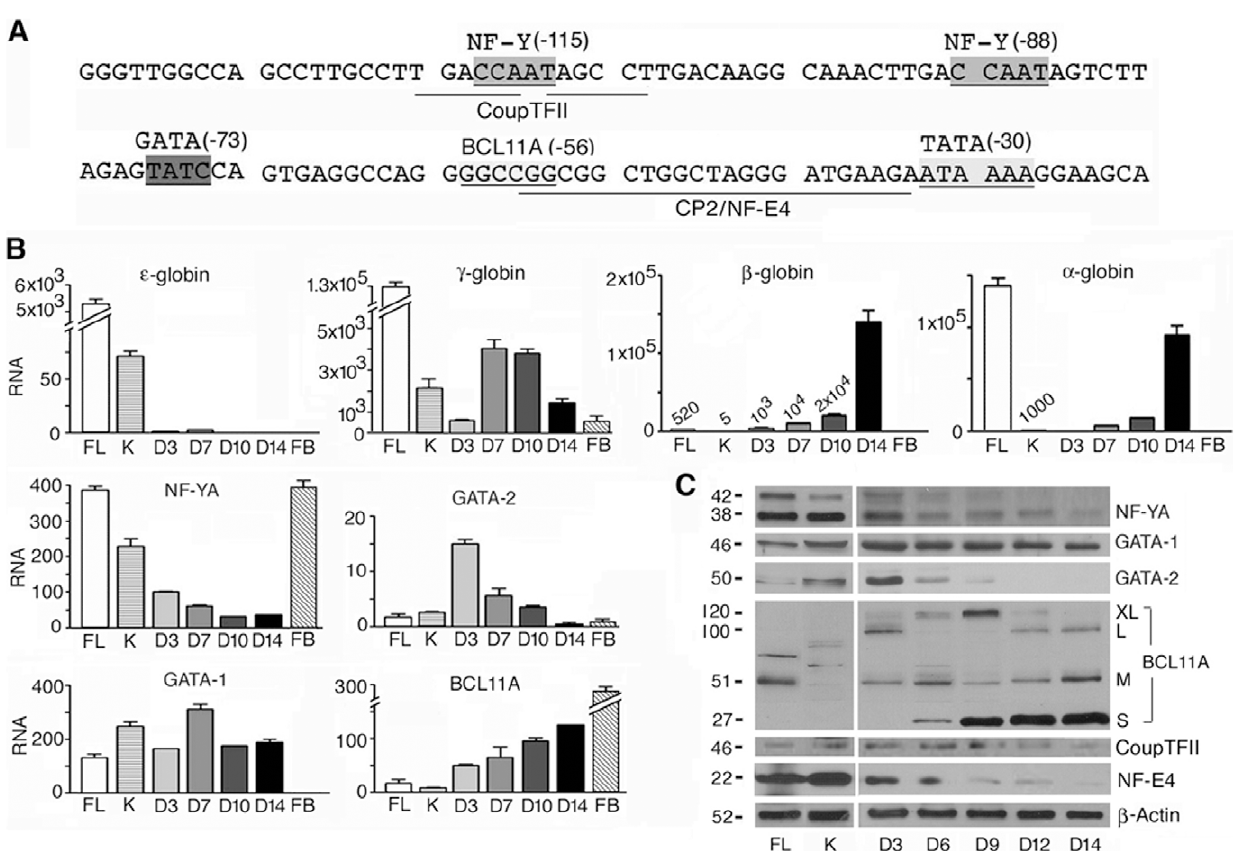
Figure 1. Expression profiles of human globin genes and transcription factors that bind to the proximal c -globin promoter in human fetal and adult erythroid cells. A. Sequence of the proximal c -globin promoter, which is identical in both G C - and A c -globin promoters. Shaded and/or underlined bases: DNA motifs that bind transcription factors as marked. Numbers in parentheses: first base positions in the motifs relative to the transcription start site. B. Transcription profiles of globin genes and transcription factors determined by quantitative real-time RT-PCR in total cellular RNAs isolated from human fetal liver, K562, and adult erythroid cells cultured from CD34 + cells for 3–14 days and non-erythroid human fetal brain cells, FL, K, D3–D14 and FB, respectively. In BCL11A panel, the PCR primer pair amplified all 4 different isoforms detected in Fig. 1C. The level of 18S ribosomal RNA set at 10 6 served as the reference for comparison. RNA levels in K562, fetal liver and D14 cells were averages of two separate RNA preparations; RNA levels in other cells were averages of two RT-PCR reactions. C. Protein expression profiles of transcription factors determined by Western blots. Numbers in left margin: sizes of proteins in Kd.